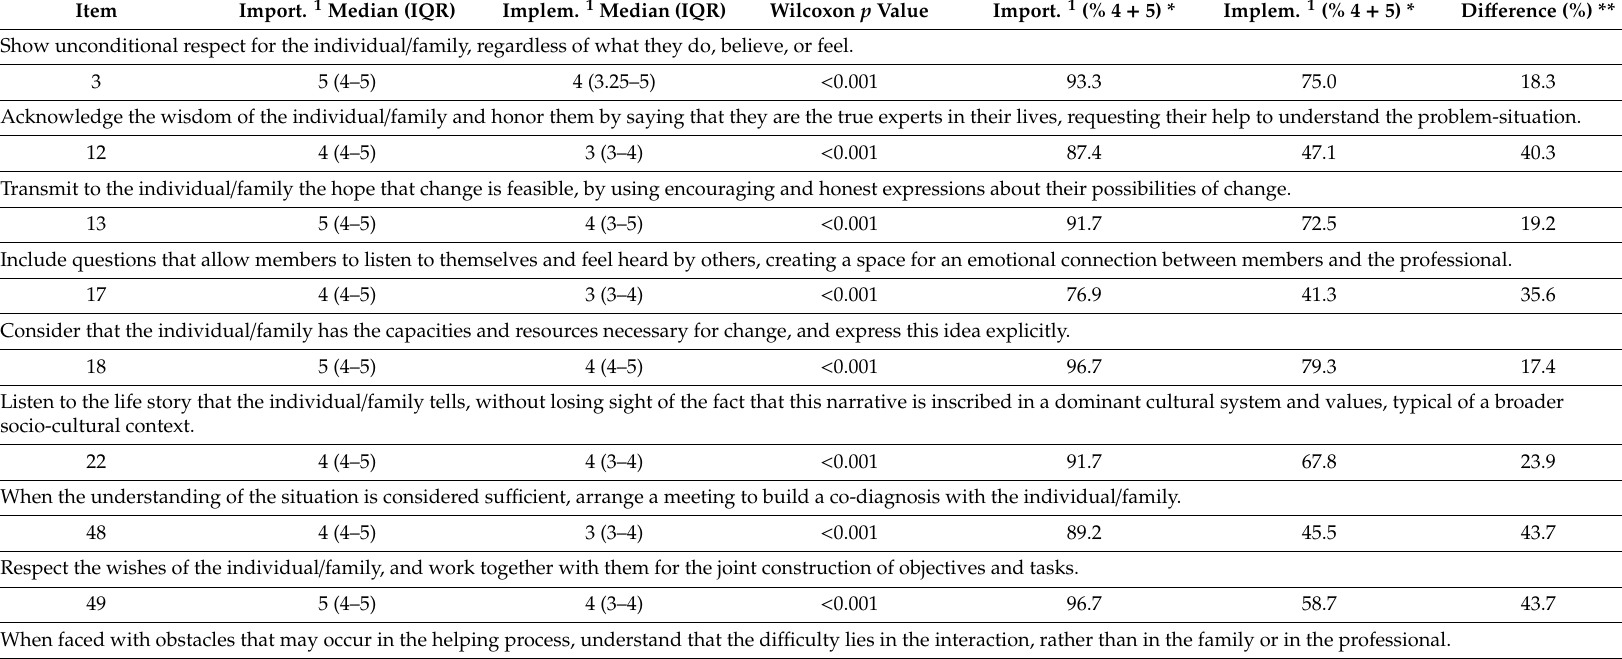
Table 5. Factor IV: assessment of the capacity-centered